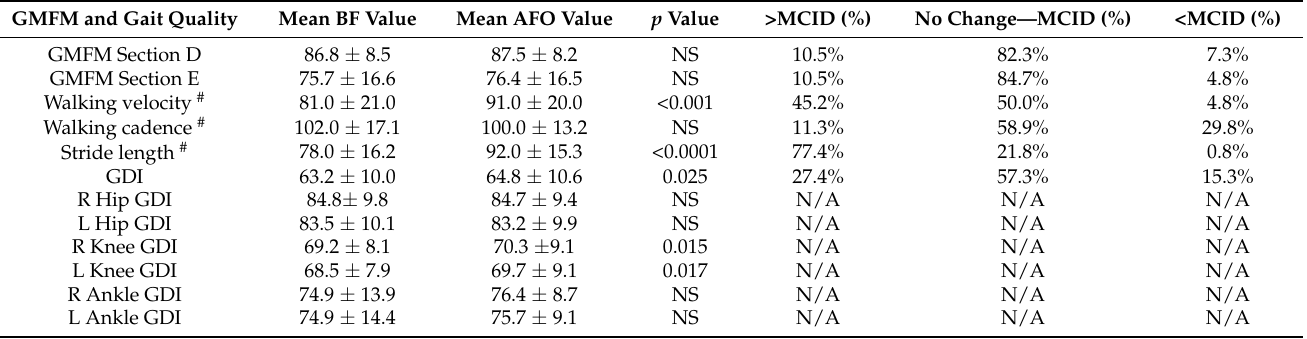
Table 3. GMFM and gait quality changes for AFO use with percentages of subjects with clinically significant